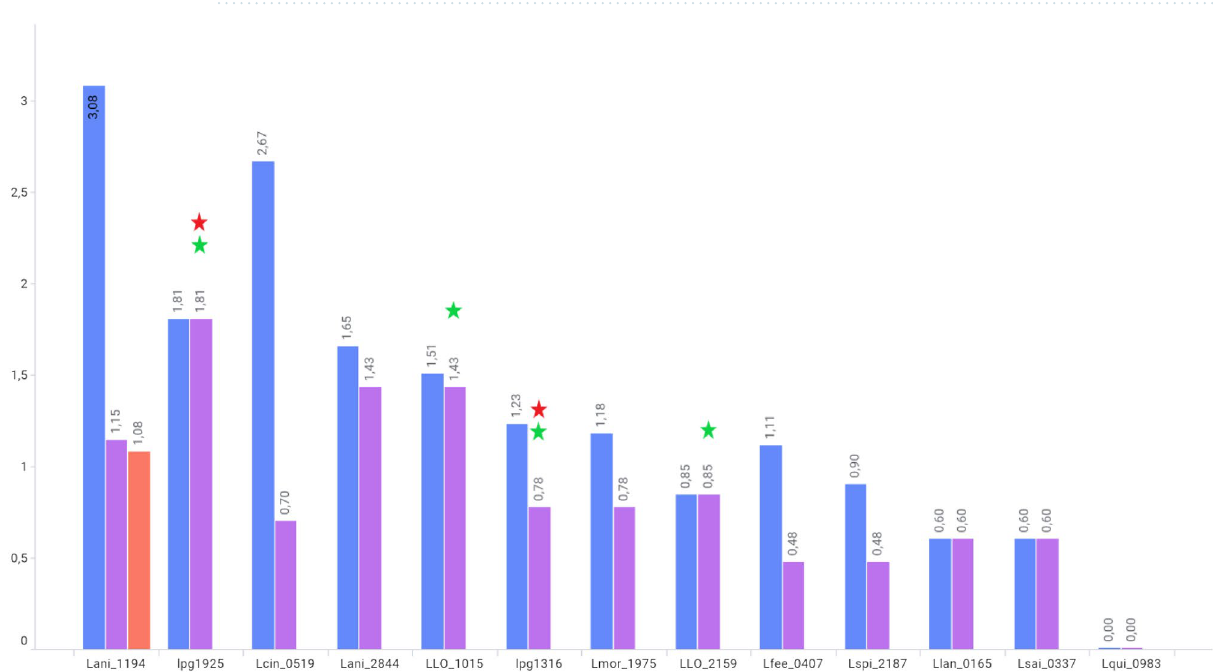
Figure 3. Numbers of species with homologs of novel Legionella kinase families. Numbers of species with homologs shown in logarithmic scale. The sequences were collected by BLAST search in the NR database (BLAST at E = 1e−4) 28–30 . Blue columns — Bacteria , purple — Legionellaceae, red — Archaea . Red asterisk — homologs present in Legionella pneumophila subsp. pneumophila str. Philadelphia 1, green asterisk — homologs in Legionella longbeachae